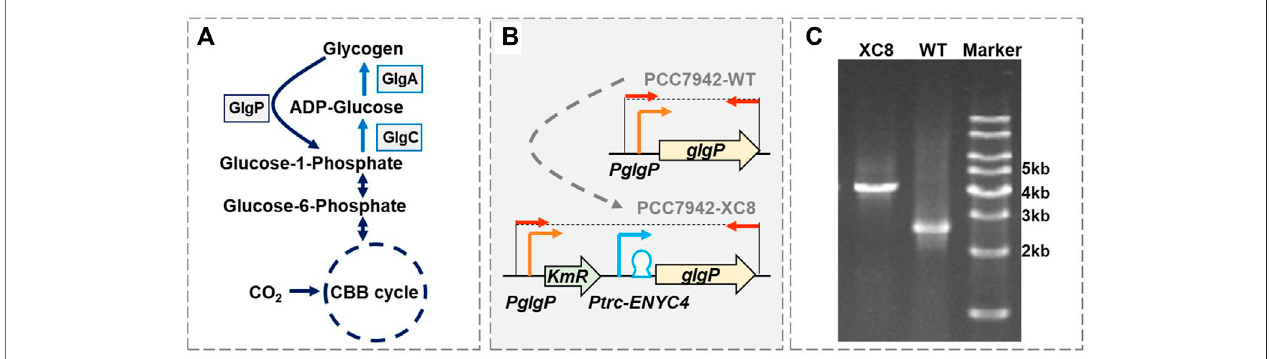
FIGURE 1 | Construction of a theophylline-responsive glgP expression system in Synechococcus elongatus PCC 7942. (A) Glycogen metabolism pathways in cyanobacteria. GlgP, glycogen phosphorylase; GlgA, glycogen synthase; GlgC, glucose-1-phosphate adenylyltransferase or ADP-glucose pyrophosphorylase; CBB cycle, Calvin – Benson – Bassham cycle. (B) Strategy for constructing the theophylline-responsive riboswitch control system for glgP expression in PCC 7942. A kanamycin resistance gene (KmR) and theophylline dose-regulated expression cassette ( Ptrc-ENYC4 ) were inserted between the native promoter of glgP ( PglgP ) and the glgP CDS, and theobtained mutant wastermed asPCC 7942XC8. Thered arrows representedtheprimer pairsused forcheckingthegenotypes ofPCC 7942 wildtype (PCC7942-WT) and XC8 mutant (PCC7942-XC8) strains. (C) Identi fi cation of the genotypes of PCC 7942 wildtype (WT) and XC8 mutant by PCR with the primers (shown as red arrows in